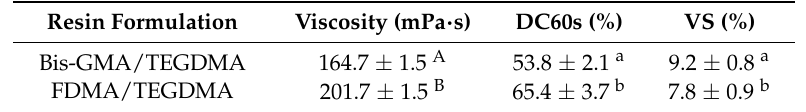
Figure 4. The curves of double conversion (DC) versus irradiation time of each dental resin system. Bis-GMA: 2,2-bis[4-(2-hydroxy-3-methacryloy-loxypropyl)-phenyl]propane; TEGDMA: triethyleneglycol dimethacrylate; FDMA: fluorinated dimethacrylate.